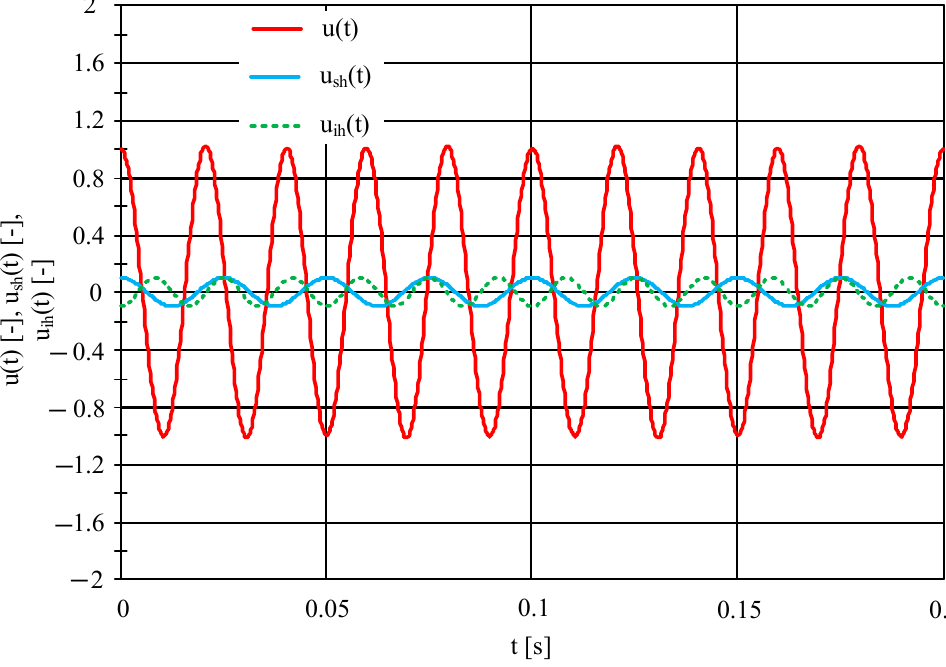
Figure 2. Subharmonic and interharmonic components and their superposition with the fundamental component for a = 0.1, f sh = 40 Hz, f ih = 60 Hz and ϕ sh = 0°, ϕ ih = 180° (phase modulation).